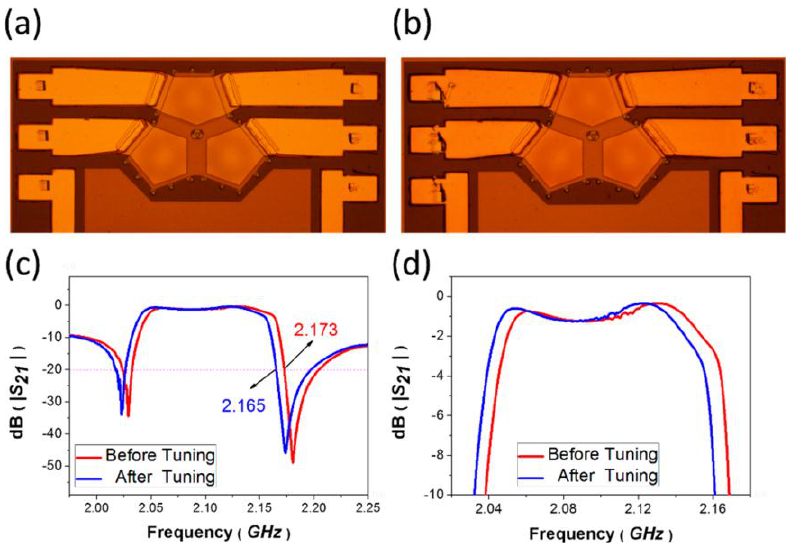
Figure 35. Frequency tuning of microresonator using molecular LbL self-assembly approach reported by Liu et al . [382]. Optical microscope images of the FBAR filter ( a ) before and ( b ) after LbL assembly. Electrical performance of ( c ) wide band and ( d ) pass band (red) before and (blue) after LbL assembly. Reused with permission from [382], Copyright 2015, American Chemical